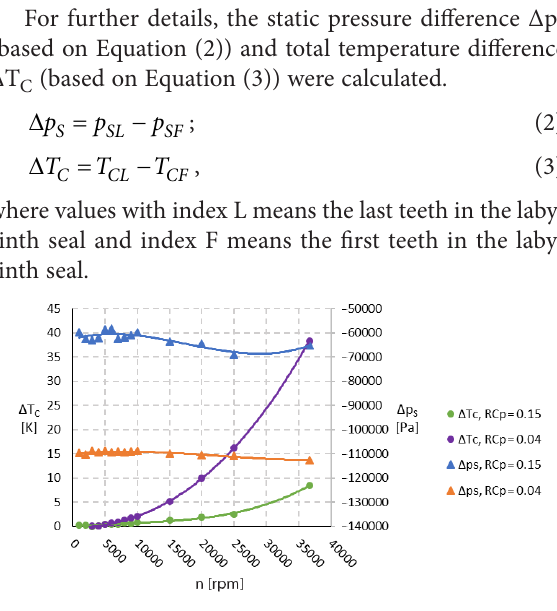
Figure 7. Static pressure and total temperature difference